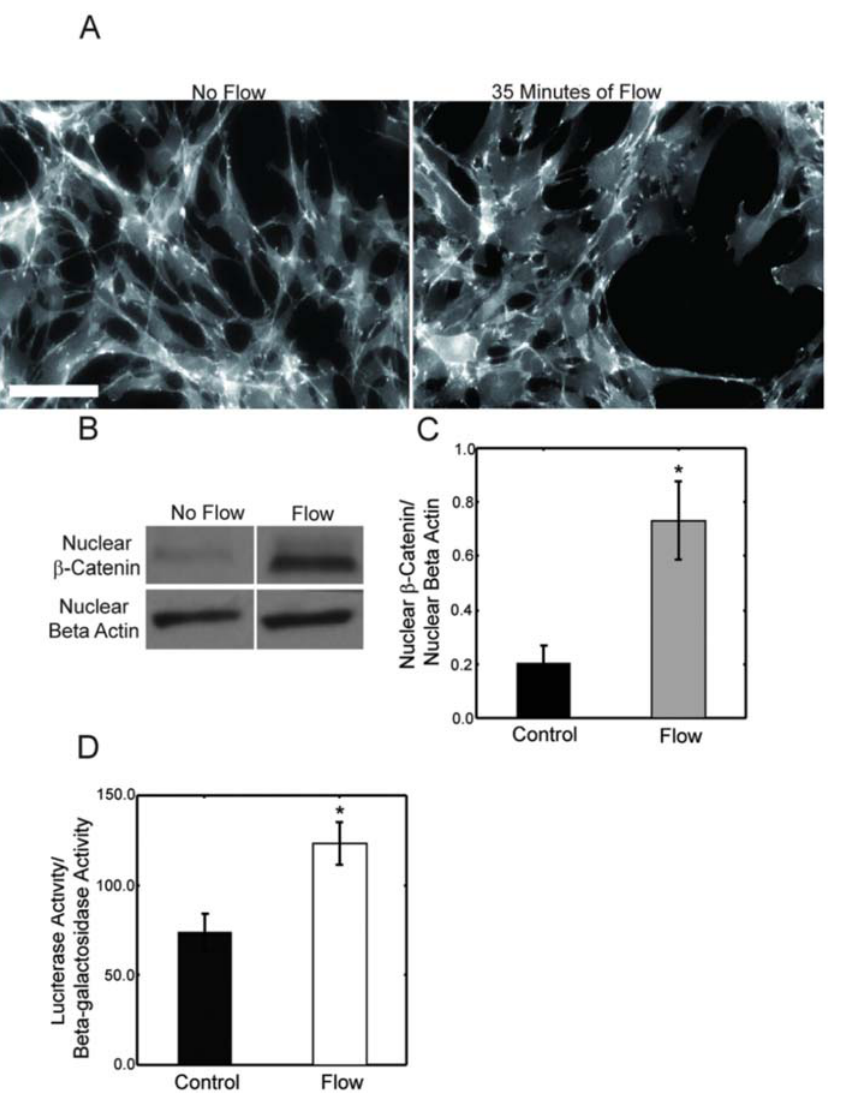
Figure 1. Oscillatory fluid flow induces b -catenin nuclear translocation and initiation of TCF/LEF associated gene transcription. (A) Immuno-staining of control and cells exposed to oscillatory fluid flow illustrate that 35 minutes of mechanical stimulation results in an increase in b - catenin localization to the nucleus. (B) To validate b -catenin translocation with flow, nuclear protein was isolated and western blot analysis was used to demonstrate that there is a 3.5 6 0.9-fold (p , 0.05) increase in nuclear b -catenin in mechanically stimulated cells versus control. (C) To determine b - catenin/TCF/LEF transcription, TOPflash transfected mouse L cells were exposed to 35 minutes of oscillatory fluid flow. A dual light luciferase assay was used to determine that mechanical stimulation induced a 2.0 6 0.4-fold increase (p , 0.05) in luciferase activity indicating an increase in b -catenin/ TCF/LEF transcription. Scale bar=100 m m. (Error bars: SEM (n $ 4)).